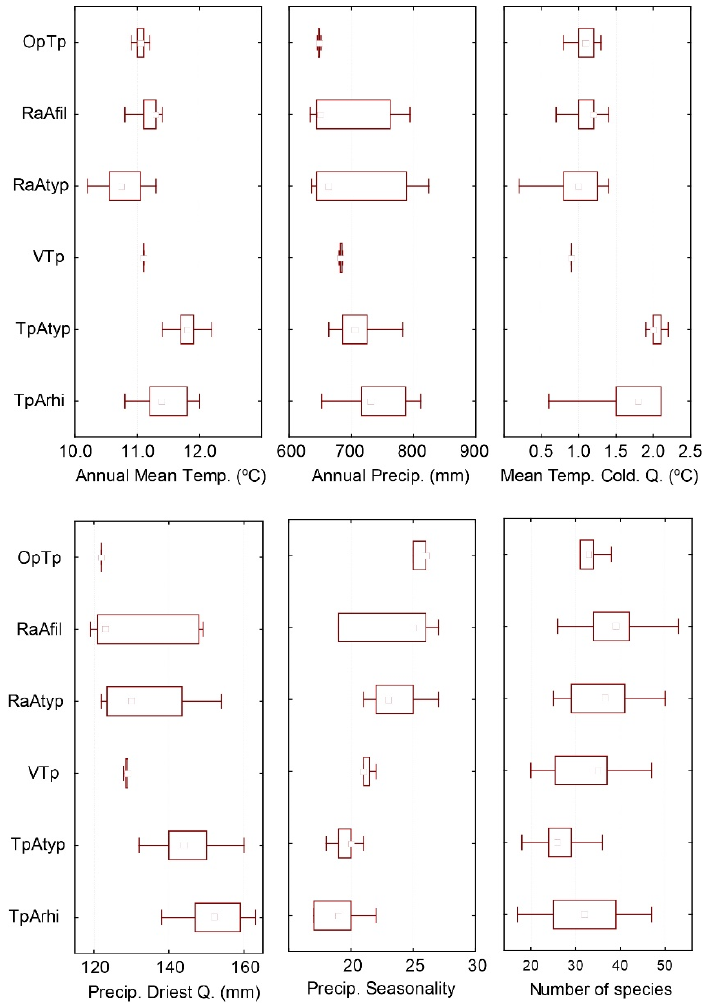
Figure 5. Macroclimatic features represented by annual mean temperature, annual precipitation, mean temperature of the coldest quarter, precipitation of the driest quarter, and precipitation seasonality and number of species. The legend is the same as in Figure 3.